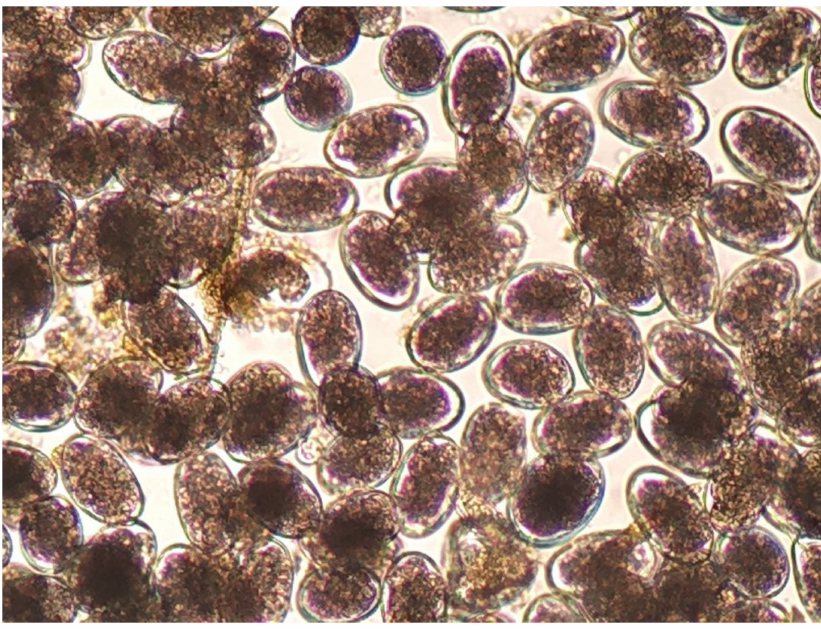
Figure 2. Haemonchus eggs as seen during microscopic observation (75 × 45 µ